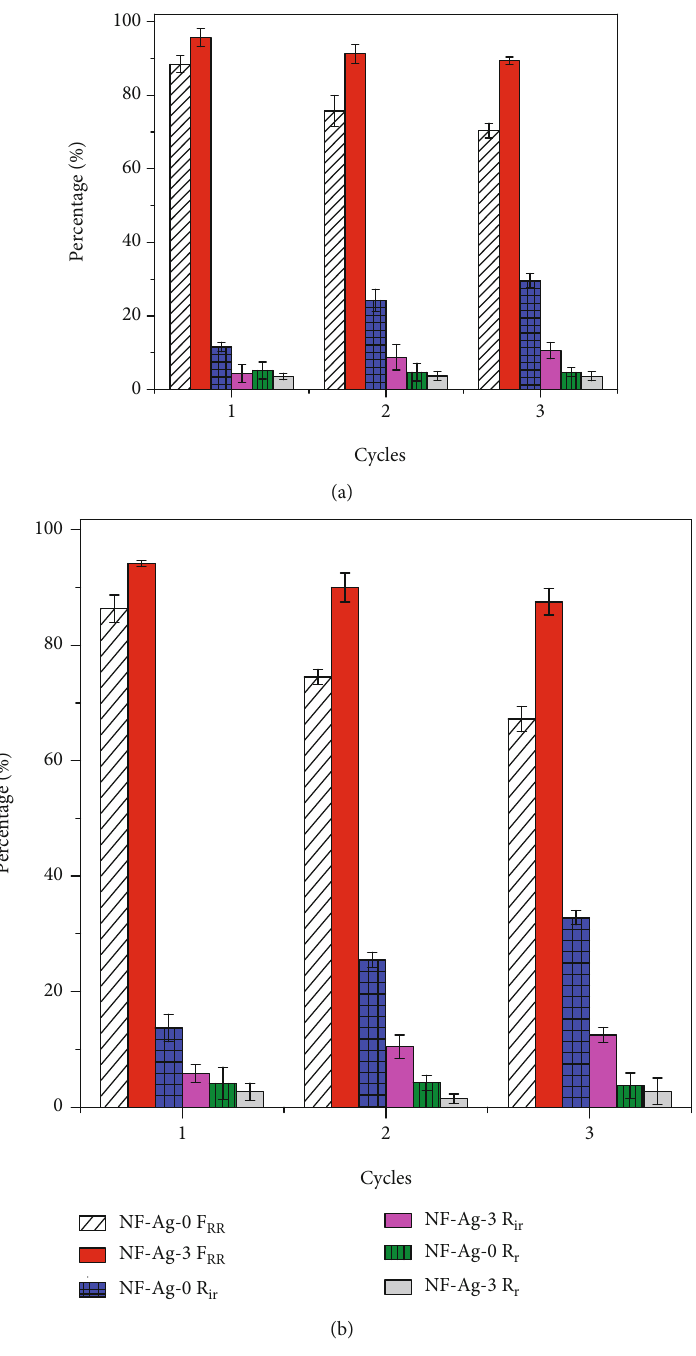
Figure 11: Antiprotein adsorption with NF-Ag-3 membrane. (a) BSA; (b)